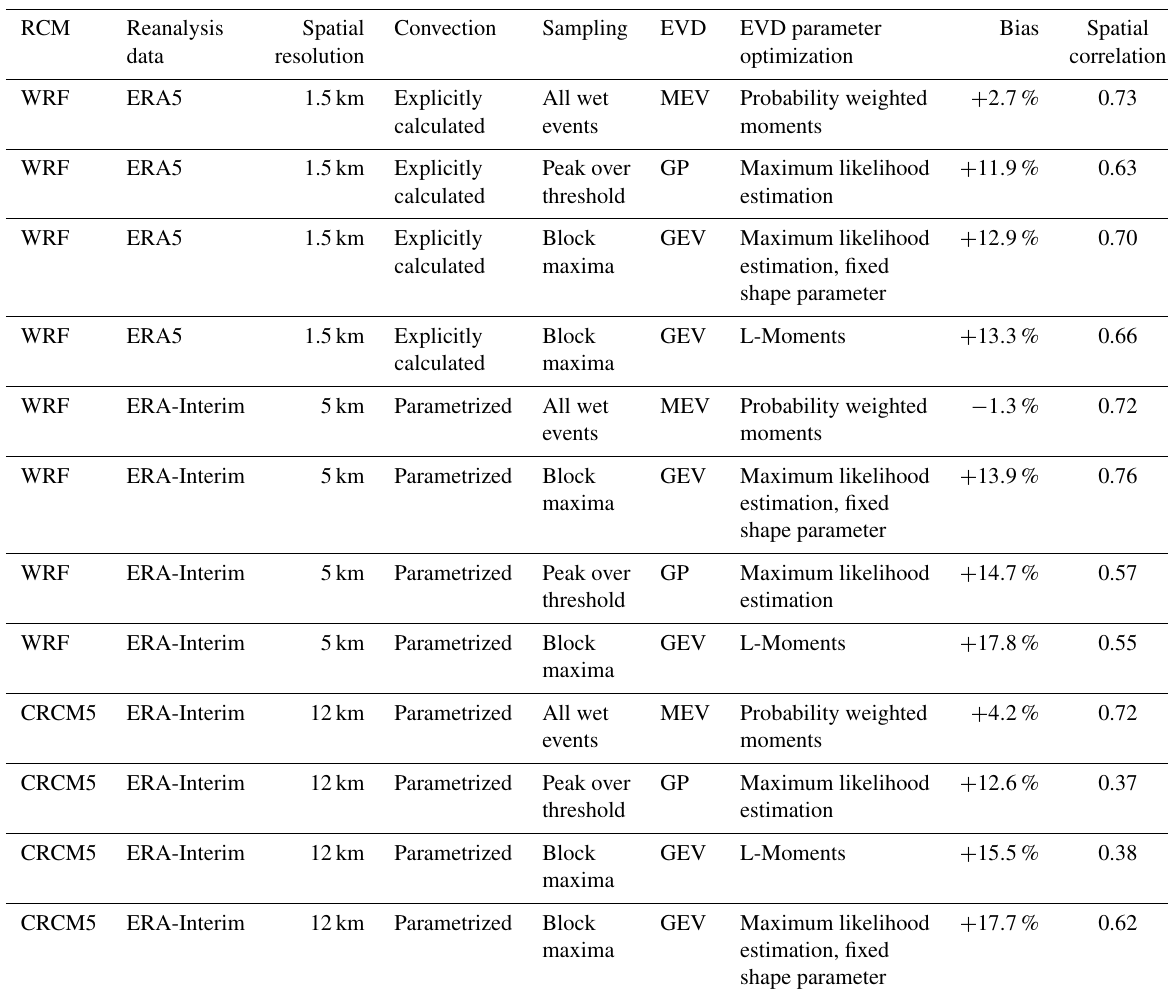
Table 3. Summary of the applied RCM setups and EVT approaches. Performance metrics of the comparison to observational 100-year return levels are given in terms of the spatially averaged bias and spatial correlation (Spearman). The entries are sorted first by resolution and then by amount of